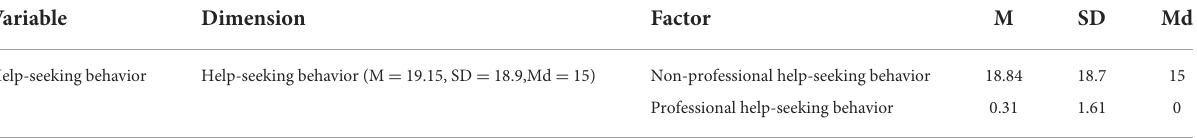
TABLE 6 Scores of help-seeking behavior of the postgraduates in the past 6 months. Variable